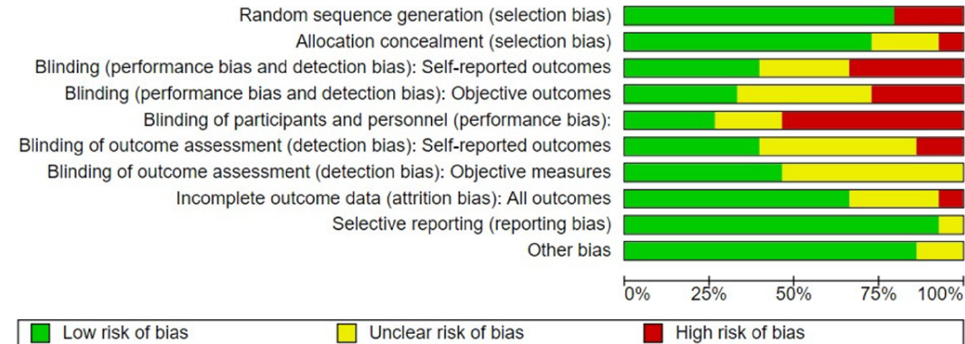
Figure 2. Risk of bias